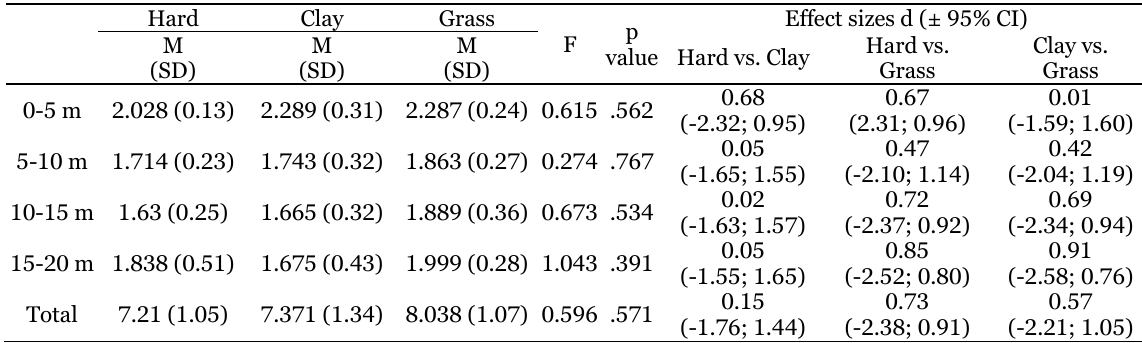
Table 3. Mean (M), standard deviation (SD) in seconds, statistical differences (p) and effect sizes (d) of the time spent in the 20 m sprint test.